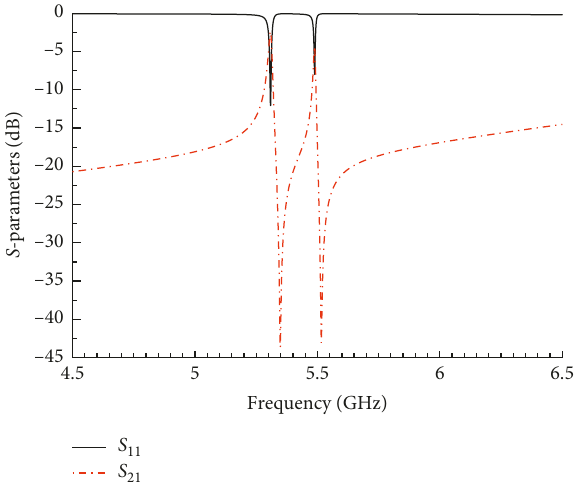
Figure 14: Simulated transmission responses of the third proposed resonator (structure b).